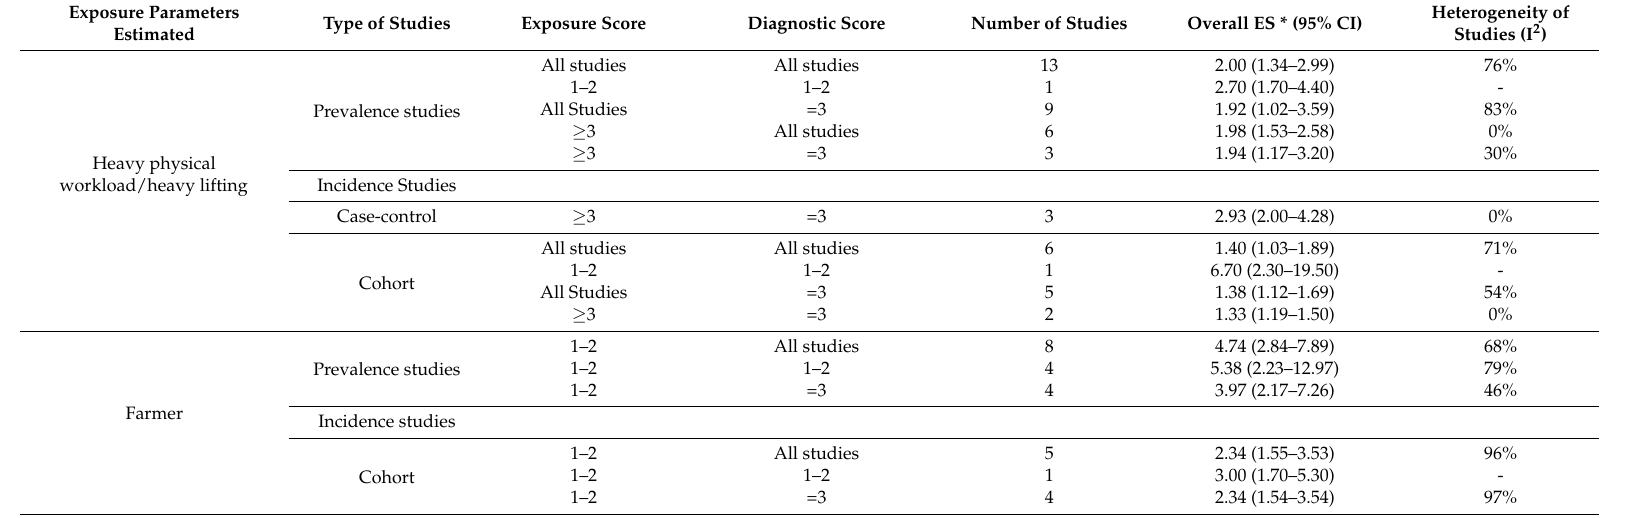
Table 4. Results of meta-analysis depending on the type and quality level of published